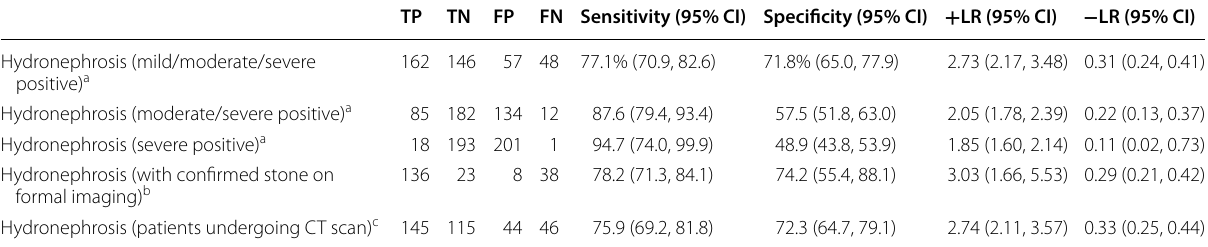
Table 3 Sensitivity, specificity, positive-likelihood ratio and negative-likelihood ratio for detection of hydronephrosis with POCUS